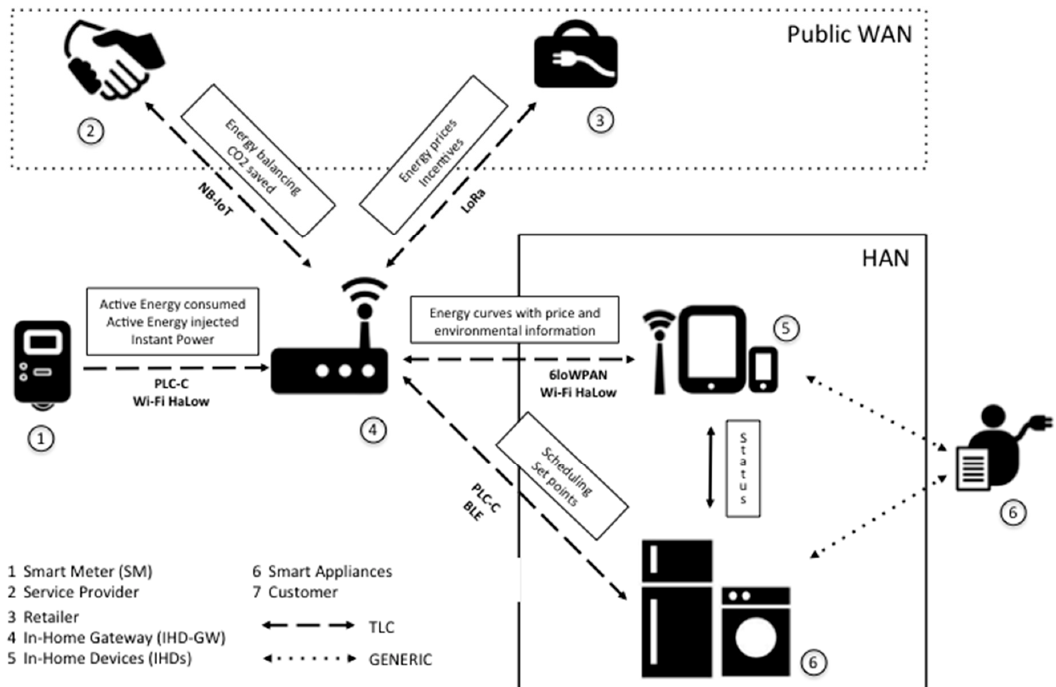
Figure 7. Example of Scheduling & Control services with Architecture 4: an IHD, acting as a gateway (IHD-GW), collects metering data from the SM using PLC-C and other information from a WAN with cellular or IoT-dedicated technologies. Finally, it calculates and/or forwards set points to the smart appliances and statistical data to the customer’s devices.